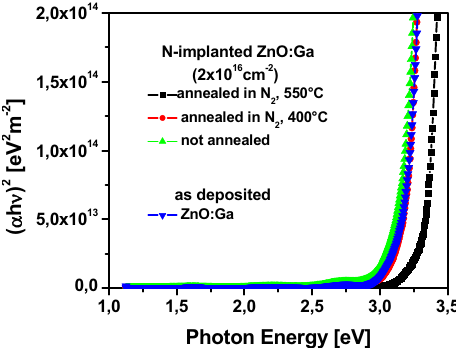
Fig. 8. Plot of the absorption squared ( αhν ) 2 versus phonon energy for (a) as deposited ZnO:Ga films (blue line), and N- implanted ZnO:Ga films (implant dose of 2 × 10 16 cm − 2 ) (b) not annealed (green line); (c) annealed in N 2 at 400 for 10 s (red line); (c) annealed in N 2 at 550 for 10 s (black